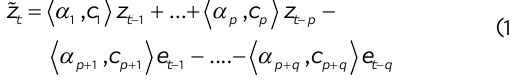
Calculating the final intervals of the hybrid model